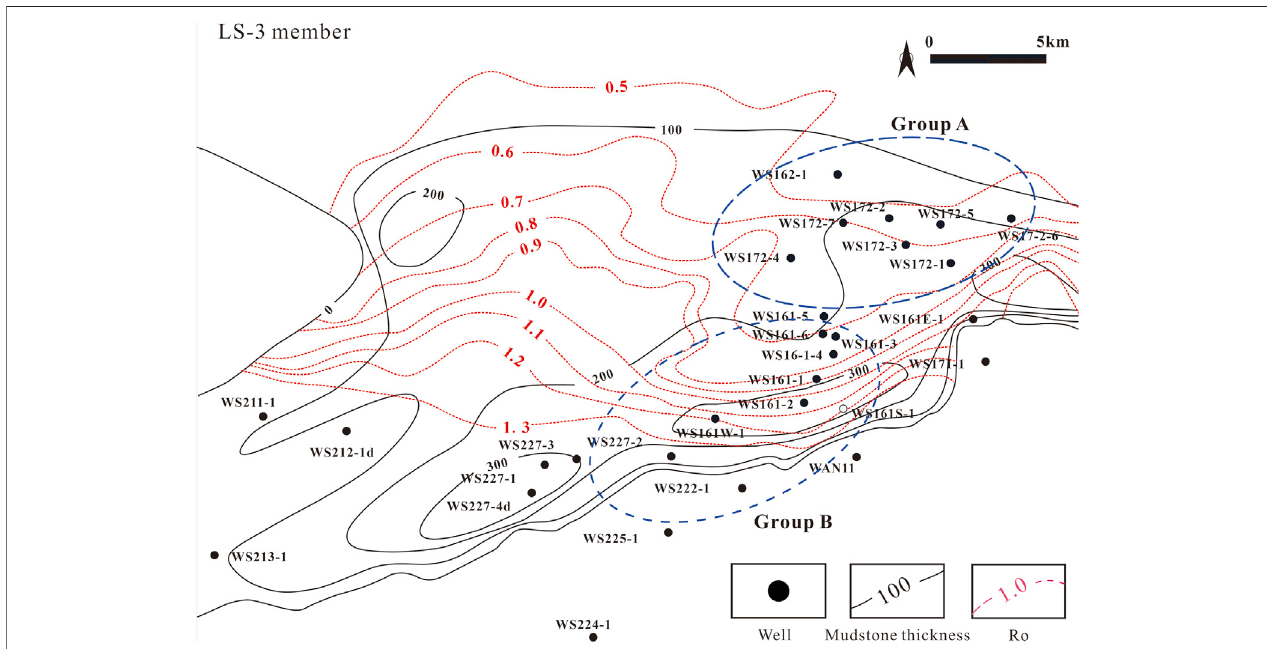
FIGURE9| Thedistributionofmudstone thicknessandmaturityofthethirdoftheLiushagangFormation(LS-3member)intheWushiSag(modi fi edafter(Liuetal., 2018)).